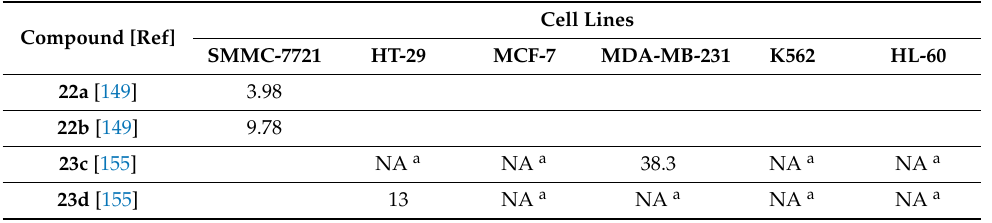
Table 6. IC 50 values (µM) for zinc complexes 22a , 22b and 23c , 23d against different tumor cell lines after an incubation time of 72 h. after an incubation time of 72 h.